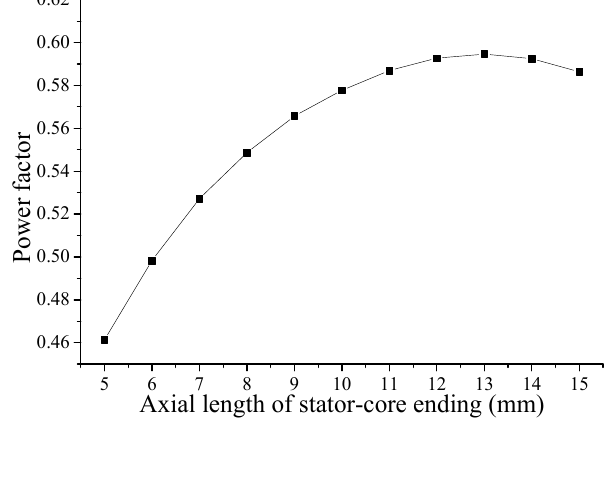
Figure 16. Variation of power factor versus axial length of stator-core ending.